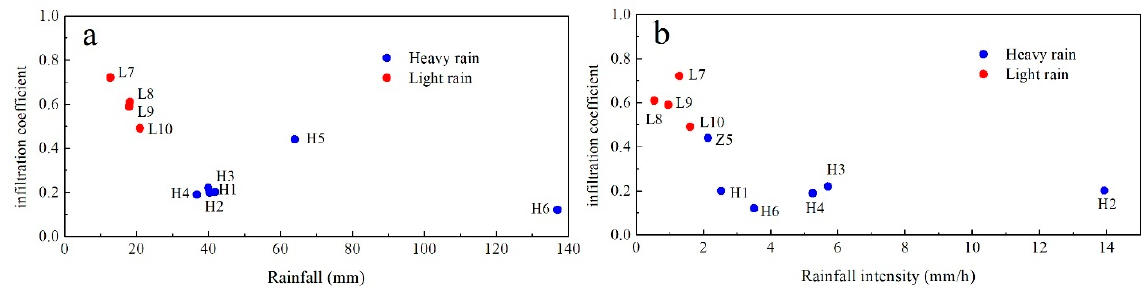
Figure 9. ( a ) Relation between rainfall infiltration coefficient and rainfall amount; ( b ) Relation between rainfall infiltration coefficient and rainfall